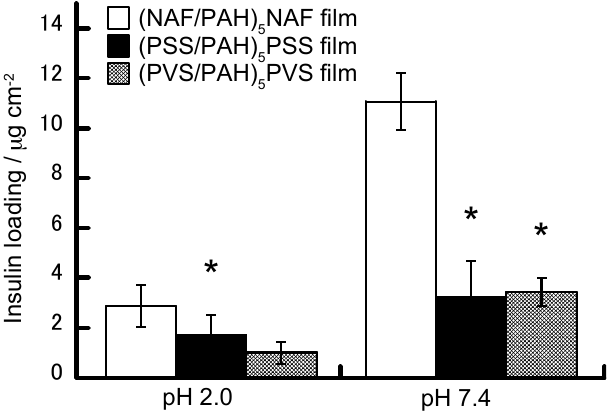
Figure 5. Insulin loading on (NAF/PAH) 5 NAF (open columns), (PSS/PAH) 5 PSS (filled columns), and (PVS/PAH) 5 PVS (half-filled columns) films. The LbL films were exposed to a 0.1 mg mL − 1 insulin solution with 10 mM acetate buffer (pH 2) or 10 mM Tris buffer (pH 7.4). All buffer solutions contained 150 mM NaCl. * p < 0.05 one-way analysis of variance (ANOVA) and Dunnett’s test vs. (NAF/PAH) 5 NAF film. Note: Poly(styrene sulfate) (PSS) and poly(vinylsulfonate) (PVS).